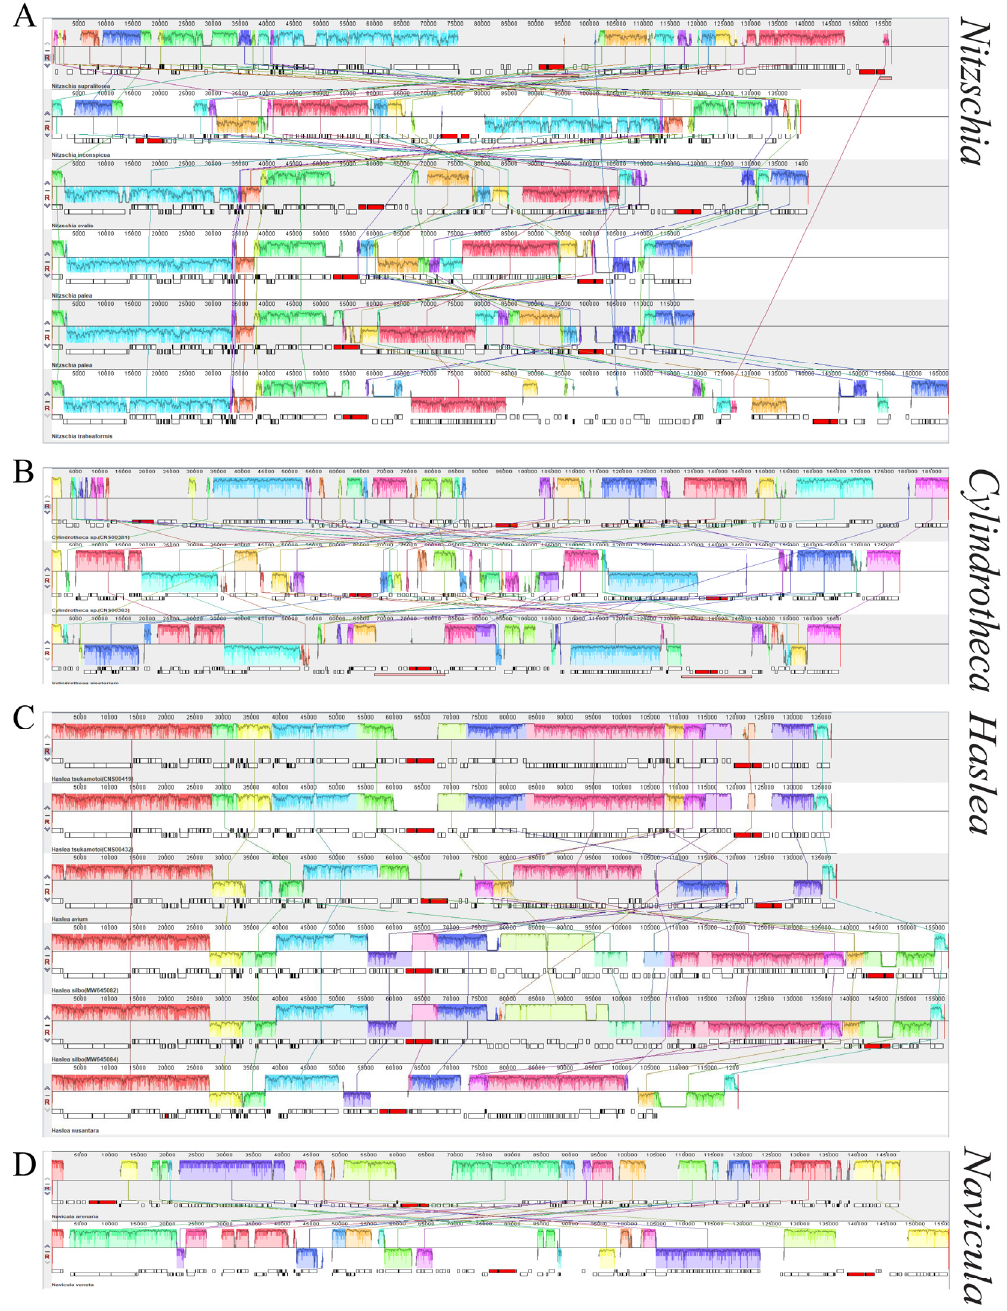
Figure 6. Synteny analysis of cpDNAs. ( A ) Synteny analysis of Nitzschia cpDNAs ( B ) Synteny analysis of Cylindrotheca cpDNAs. ( C ) Synteny analysis of Haslea cpDNAs. ( D ) Synteny analysis of Navicula cpDNAs. Each colored block indicates a synteny block among different cpDNAs.